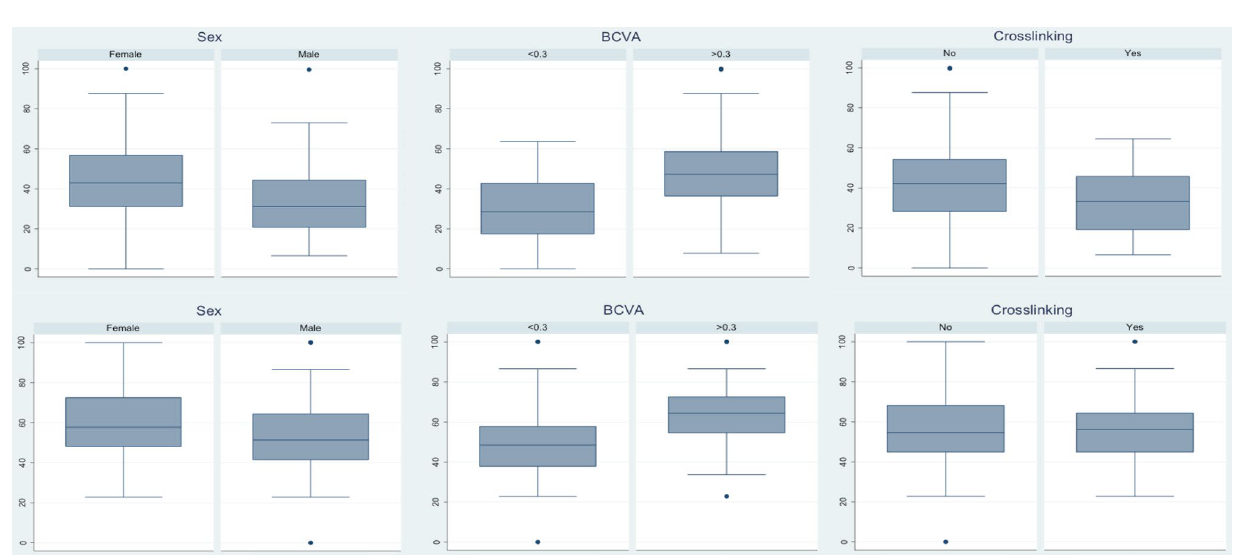
Figure 1. Above, boxplots functional score according to sex ( p > 0.05), BCVA ( p < 0.001) and crosslinking ( p = 0.02). Below, boxplots symptom score according to sex ( p > 0.05), BCVA ( p < 0.001) and crosslinking ( p >